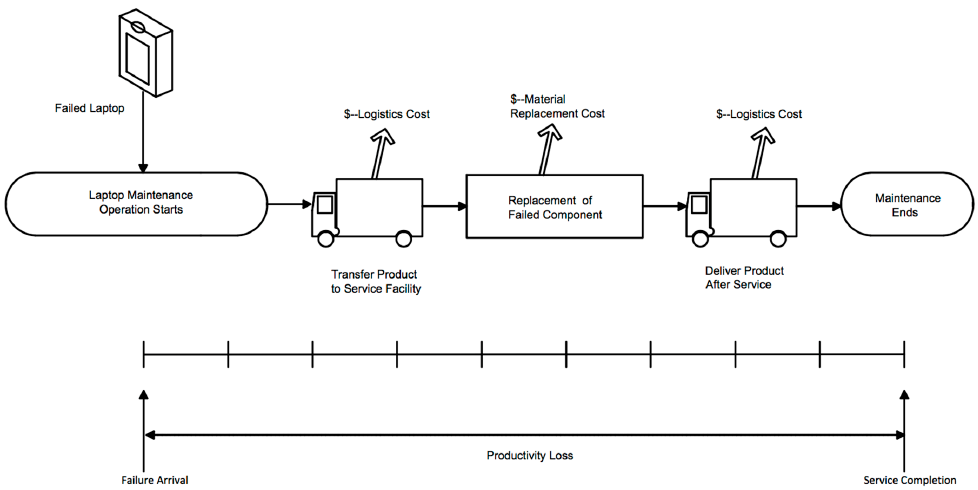
Figure 4. Maintenance operations of SEL systems.